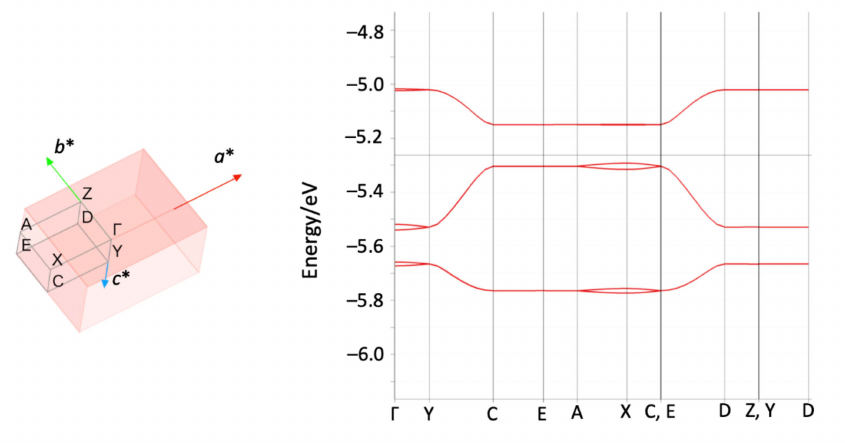
Figure 3. Brillouin zone of TTF-py2_PF6 ( left ) showing the path corresponding to the band structure of TTF-py2_PF6 ( right